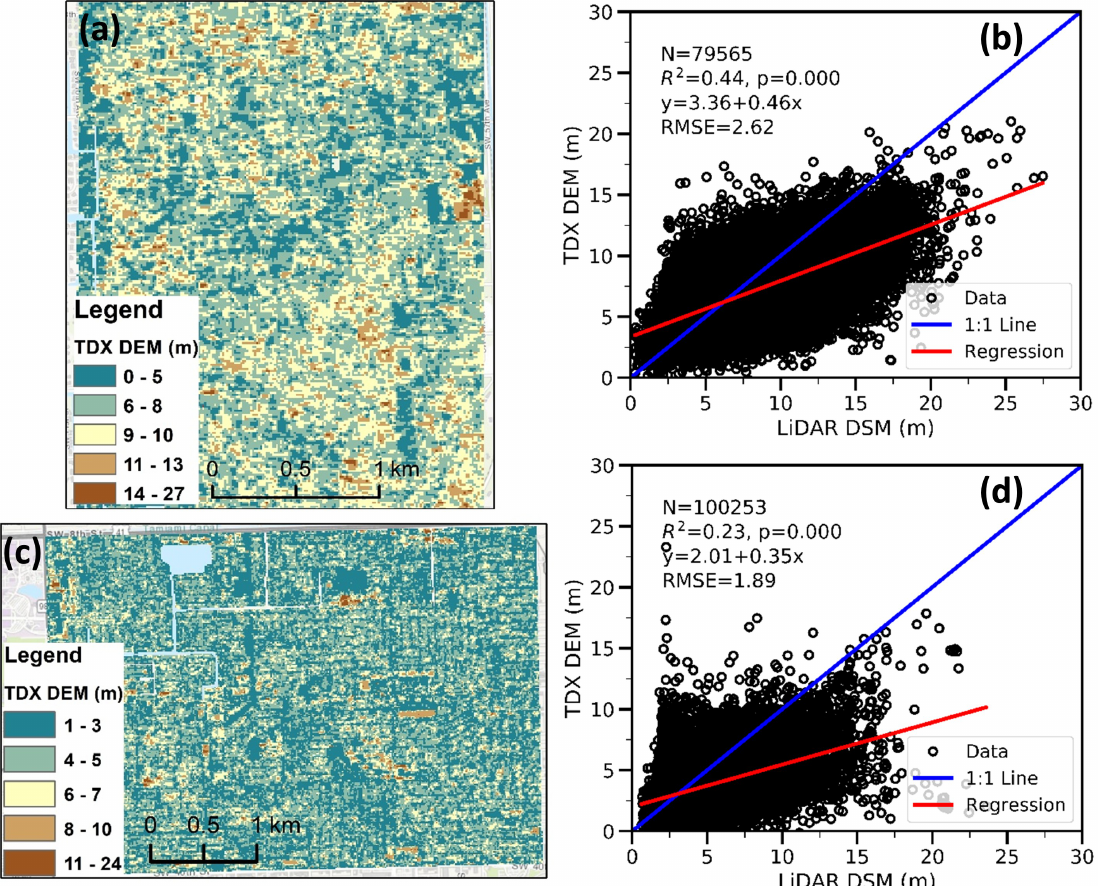
Figure 10. ( a ) TDX DEM for a sparse residential area, ( b ) scatter plot of LiDAR DSM and TDX DEM elevations for the sparse residential area, ( c ) TDX DEM for a dense residential area, and ( d ) scatter plot of LiDAR DSM and TDX DEM elevations for the dense residential